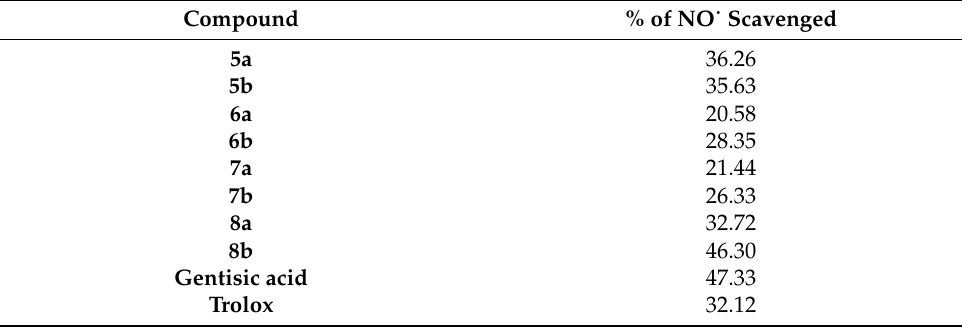
Table 3. Results of the NO ˙ scavenging